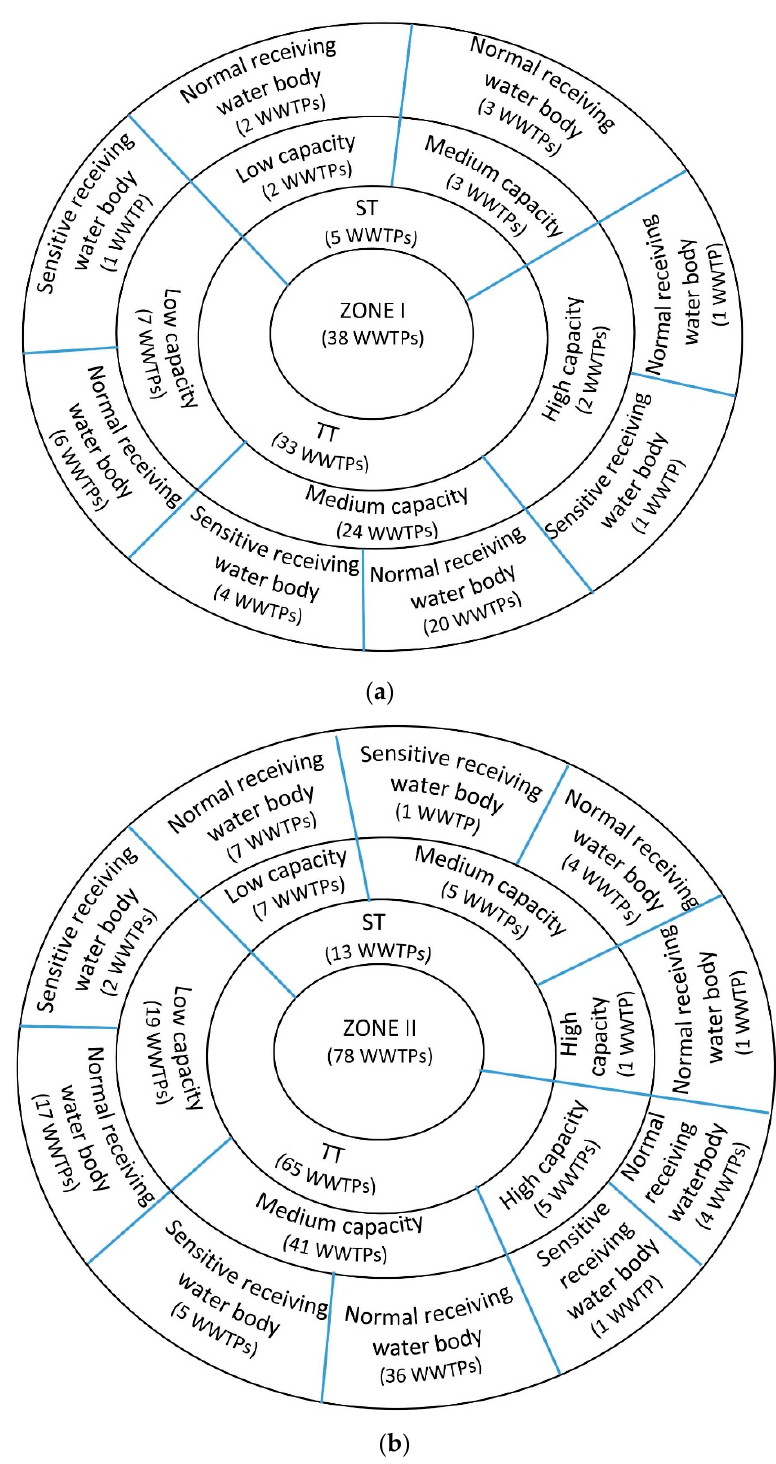
Figure 4. Categorization of the WWTPs samples examined in this study for: ( a ) Zone I of EHZ and ( b ) Zone II of EHZ.